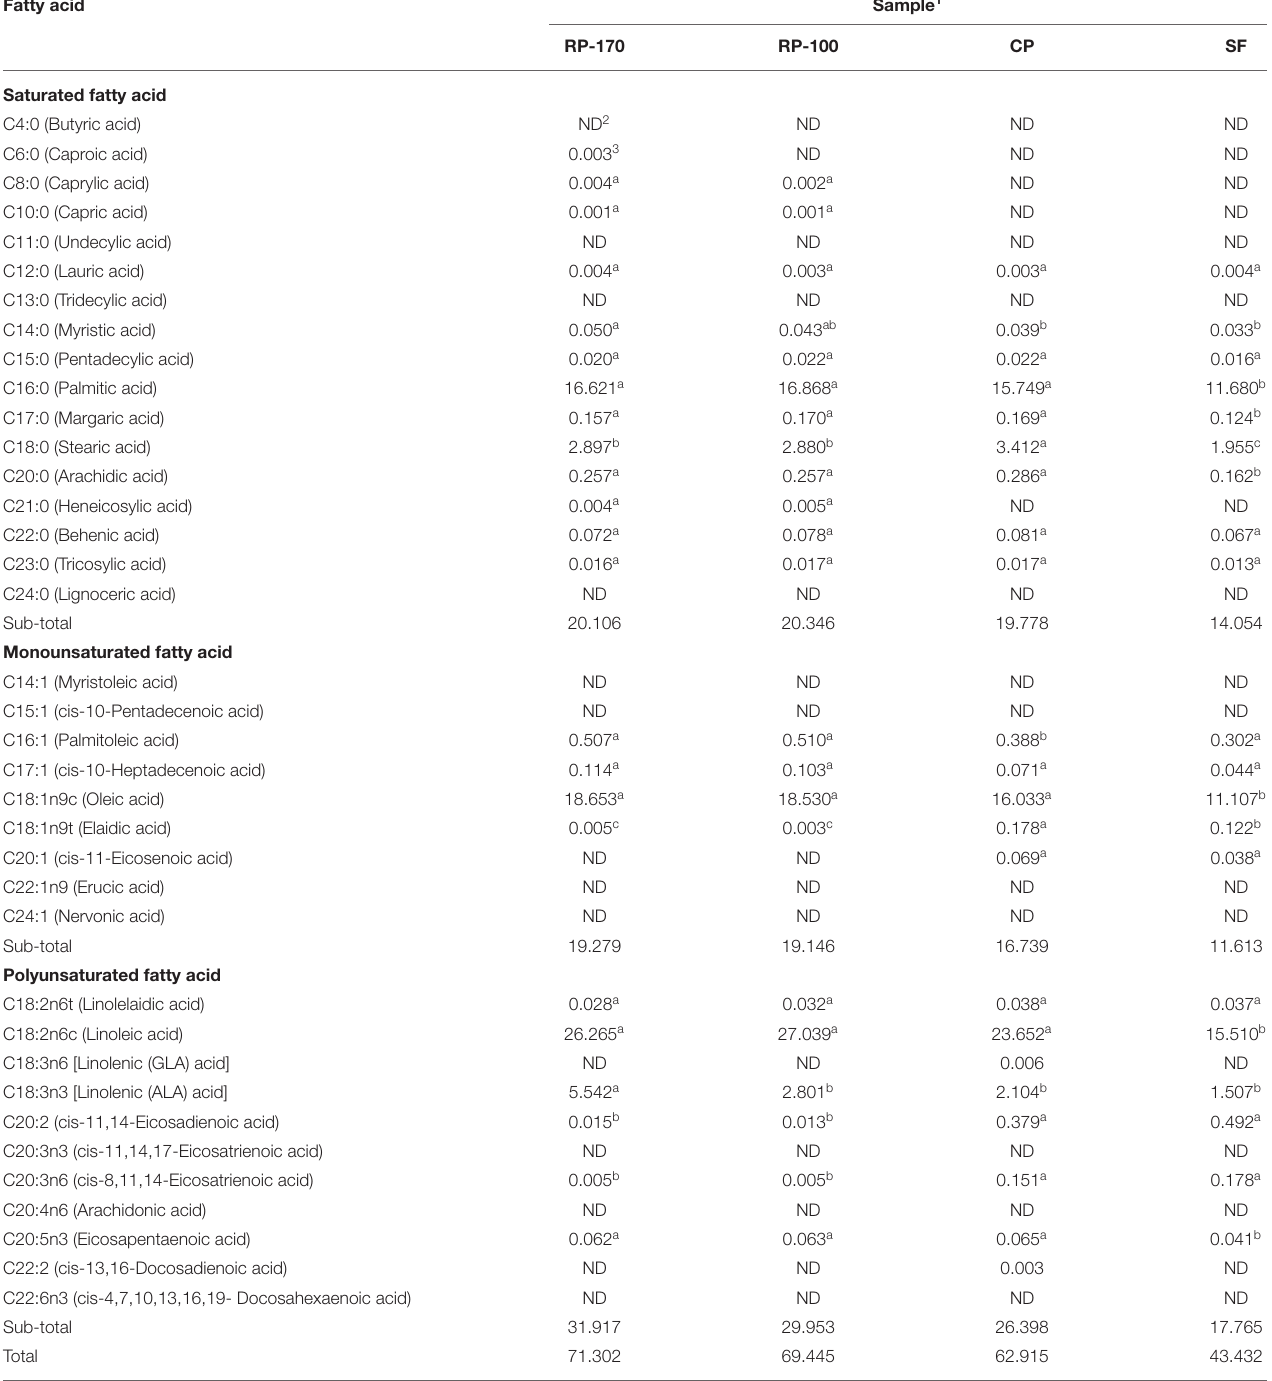
TABLE 6 | Fatty acid content of lemon seed oils extracted using different extraction methods (g/100g). Fatty